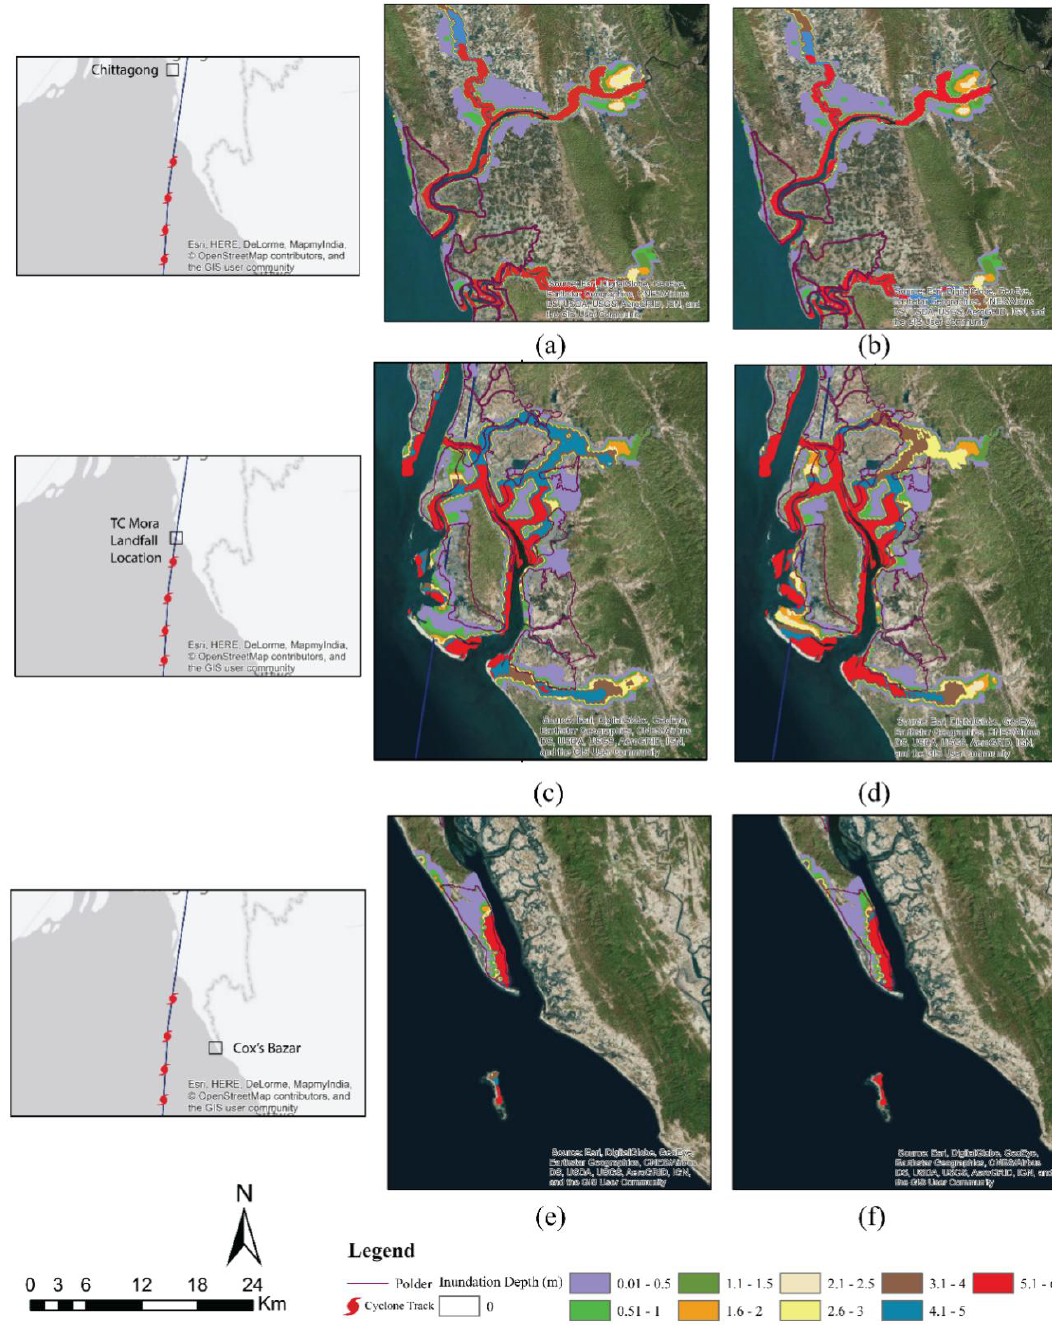
Figure 8. Inundation extent at Chittagong—( a ) TC Mora, ( b ) synthetic cyclone, at TC Mora landfall location—( c ) TC Mora, ( d ) synthetic cyclone and at Cox’s Bazar—( e ) TC Mora, and ( f ) synthetic cyclone.